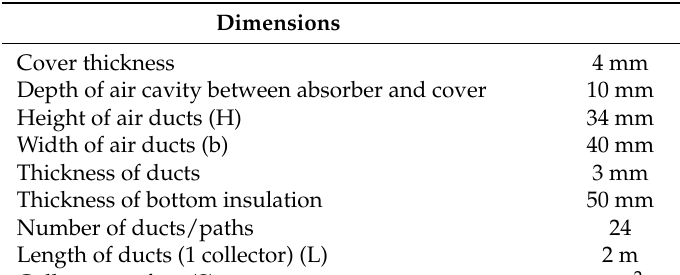
Table 1. Characteristics of each